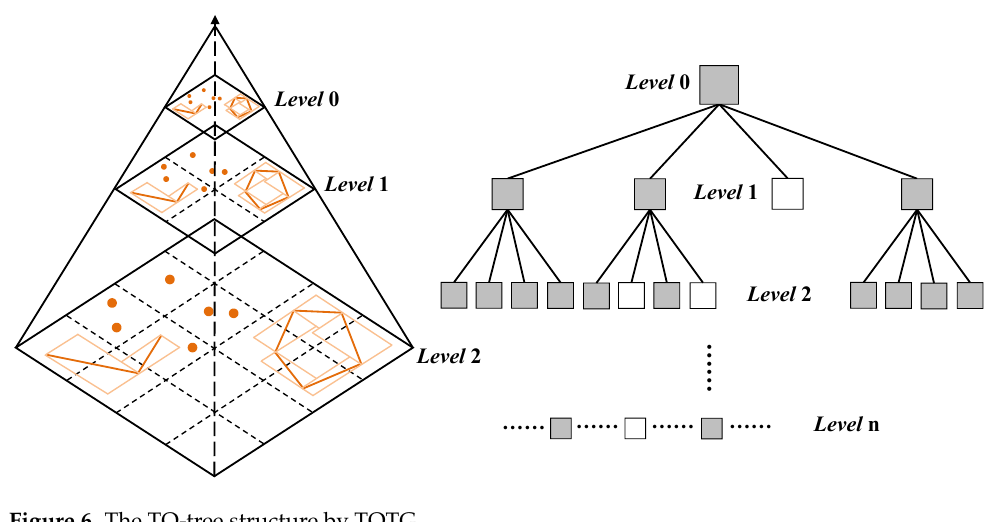
Figure 6. The TQ-tree structure by TQTG. Algorithm 1: TQ-tree generation for